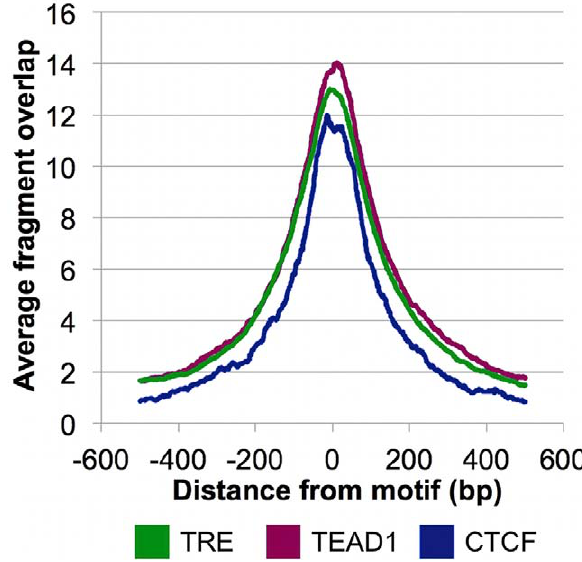
Figure 8. CSB-PGBD3 peak summits coincide with the TRE, TEAD1, and CTCF motifs. Average fragment overlaps in the vicinity of TRE, TEAD1, and CTCF motifs were plotted for the CSB-PGBD3 ChIP- seq data. The overlaps peak sharply and symmetrically around the motifs, consistent with tethering of the CSB-PGBD3 fusion protein to the corresponding transcription factors through protein-protein inter- actions.